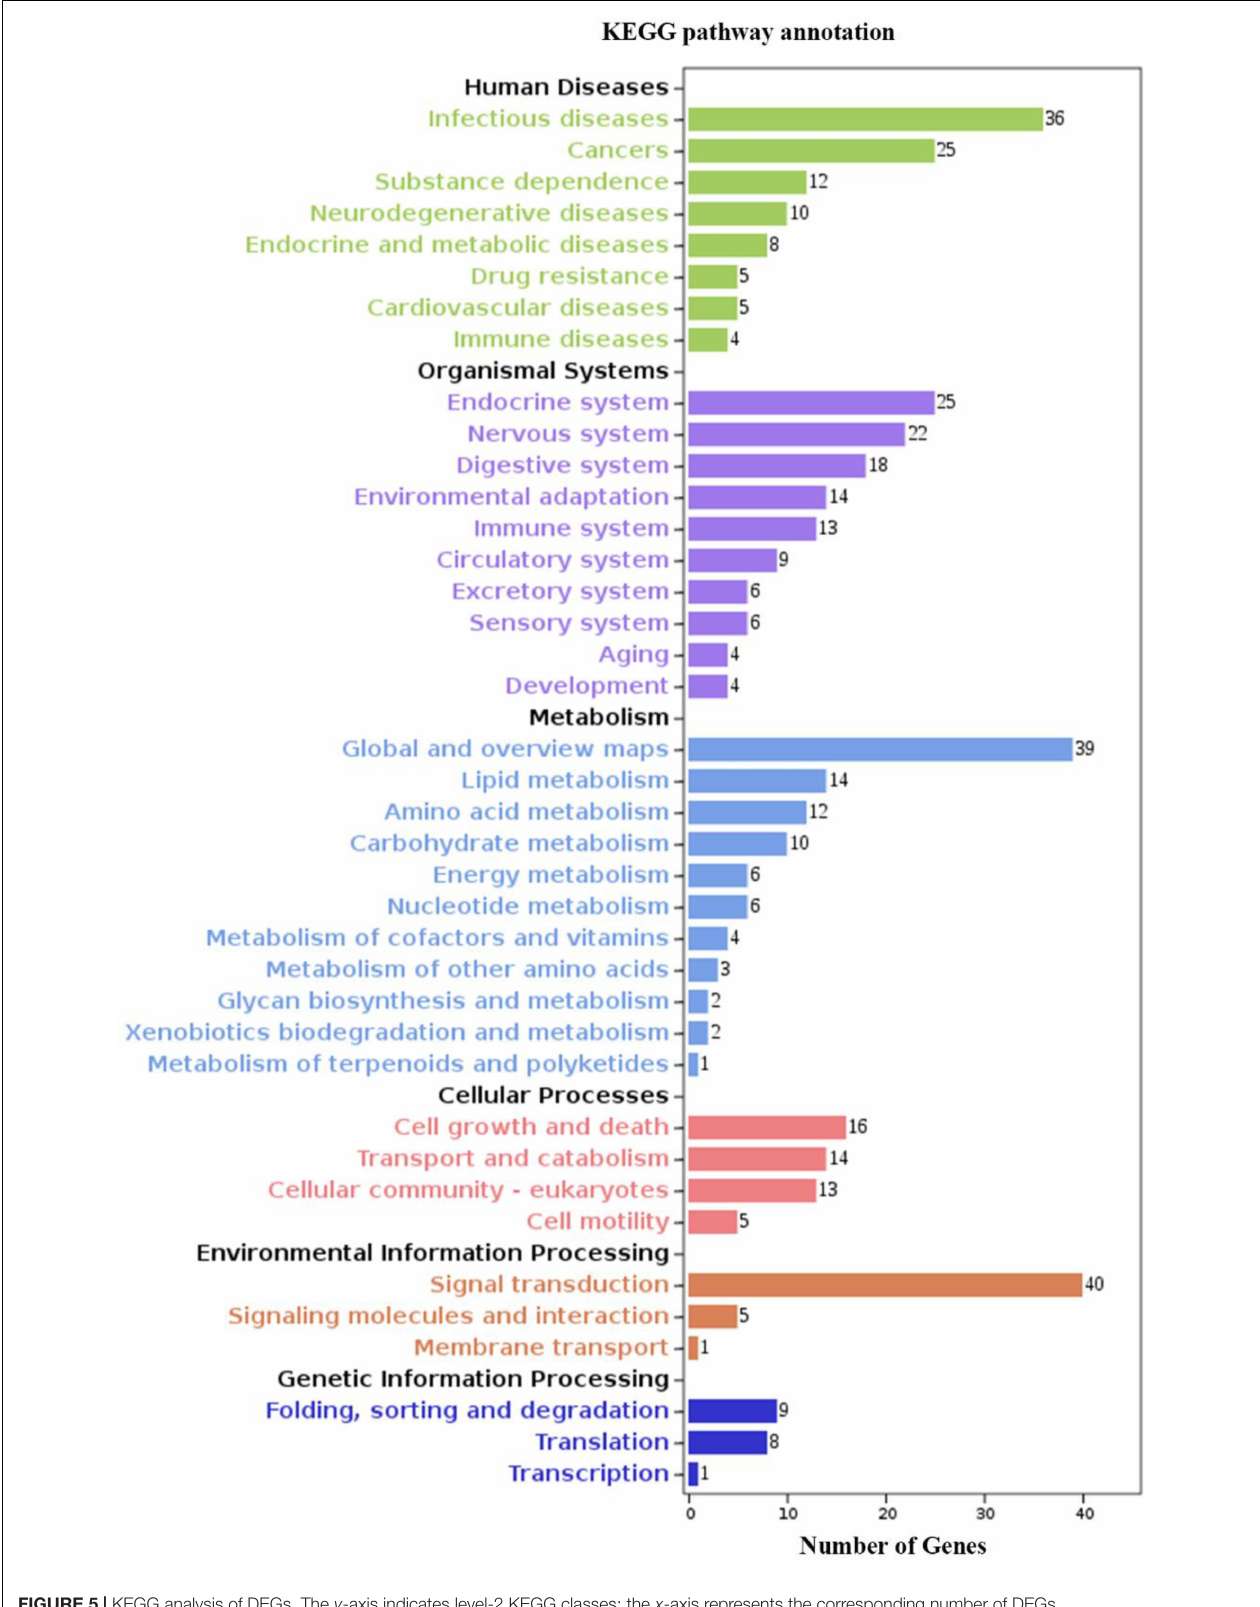
FIGURE 5 | KEGG analysis of DEGs. The y -axis indicates level-2 KEGG classes; the x -axis represents the corresponding number of DEGs.